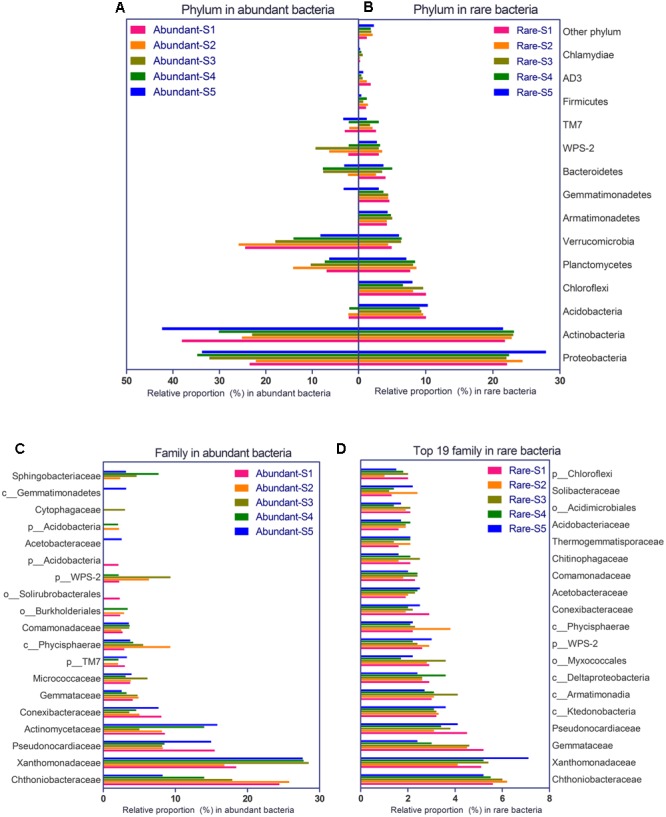
Phylogenetic composition of abundant bacteria (>1% frequency) and rare bacteria (<0.1% frequency) at the five study sites of the glacial foreland. (A) Phylum composition for abundant bacteria. (B) Phylum composition for rare bacteria. (C) Family composition for abundant bacteria. (D) Family composition for rare bacteria (193 total families were found in the rare bacteria, and the top 19 families (ranked by the average proportion in the five sites) are shown here).